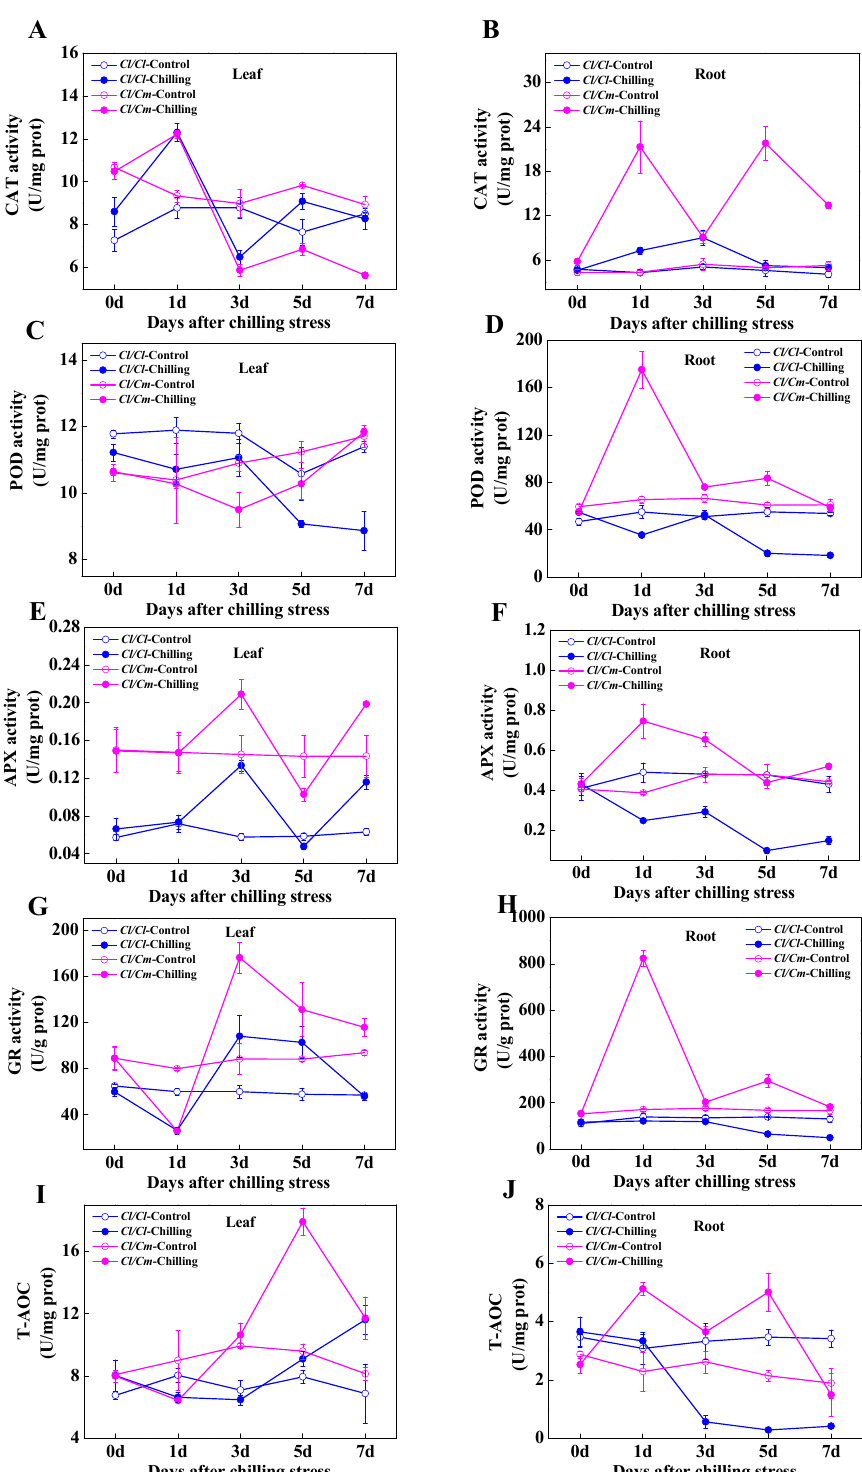
Figure 2. Dynamic changes in the activities of antioxidant enzyme system in grafted watermelon plants in response to chilling stress. ( A ) Catalase (CAT), ( C ) Peroxidase (POD), ( E ) Ascorbate peroxidase (APX), and ( G ) Glutathione reductase (GR) activities in the leaves. ( B ) CAT, ( D ) POD, ( F ) APX, and ( H ) GR activities in the roots. ( I ) Total antioxidant capacity (T-AOC) in the leaves. ( J ) T-AOC in the roots. Leaf or root samples were collected at indicated times under control (28/18 ◦ C) and chilling (10/5 ◦ C) conditions. Cl / Cl , self-grafted watermelon plants; Cl / Cm , pumpkin rootstock- grafted watermelon plants. The data are the means of four replicates with